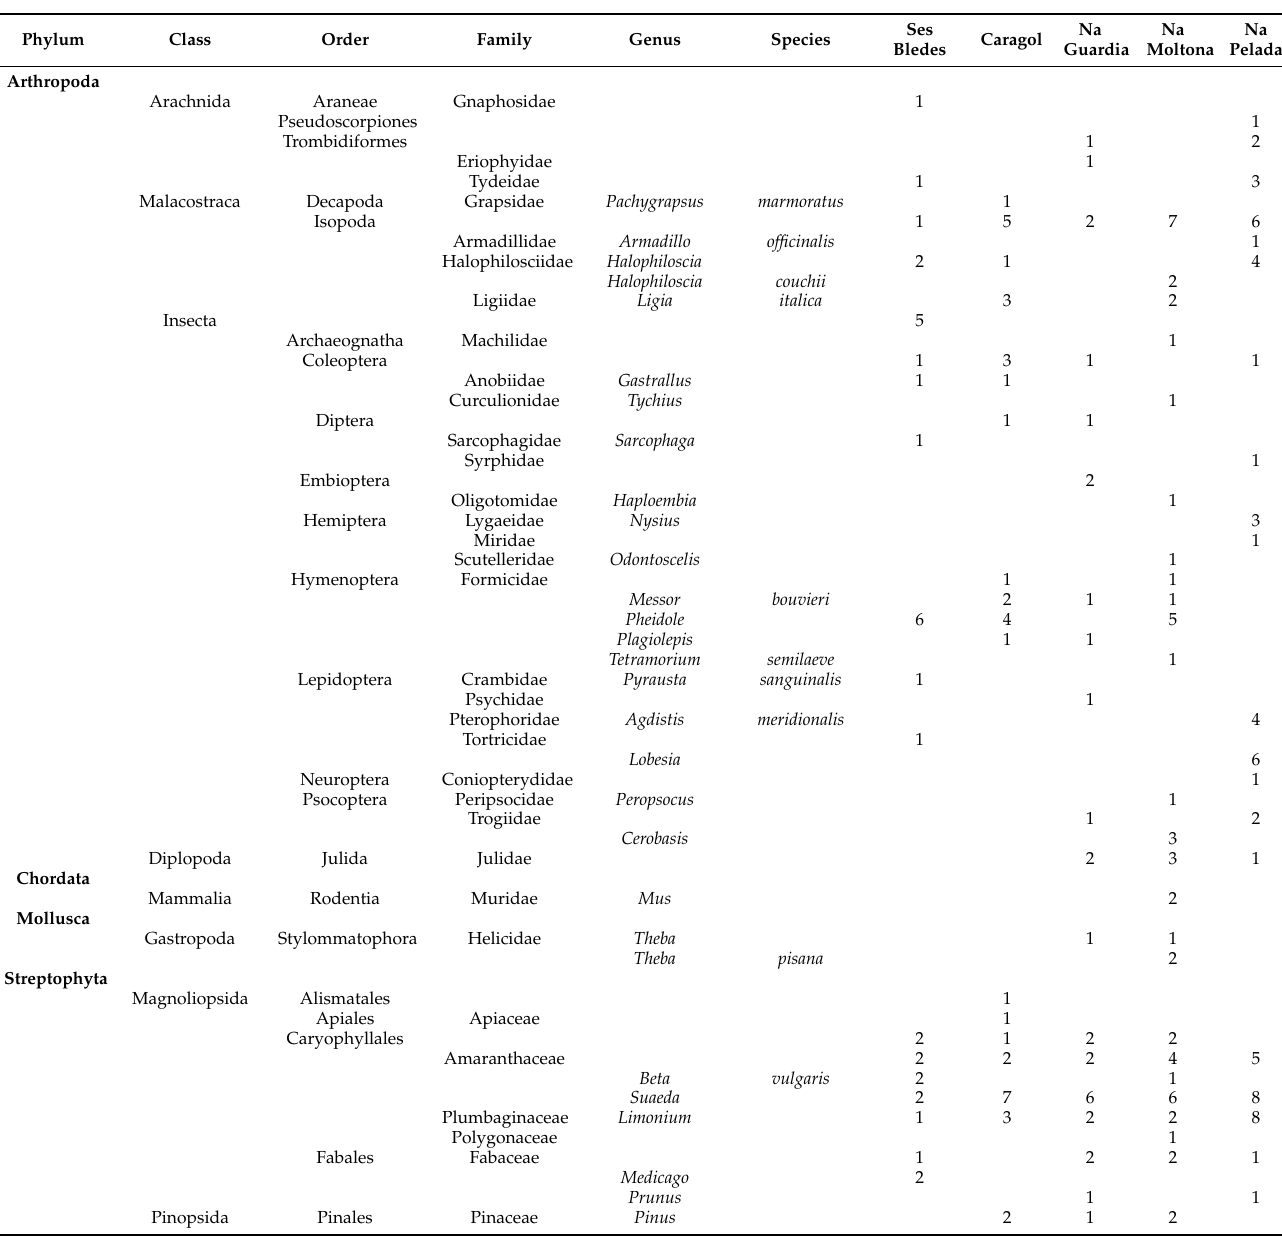
Table 1. List of the identified diet taxa to the maximum resolution obtained in the diet composition of Podarcis lilfordi through molecular analysis. We show the number of fecal samples where each taxon was